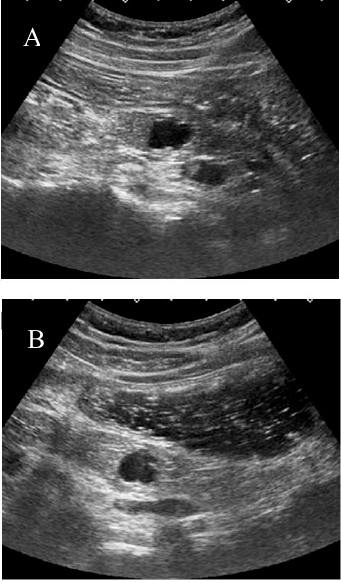
Figure 3. The liquid-filled stomach method. The pancreas tail is not well visualized due to gastric gas in normal examination ( A ). However, the pancreatic body to tail become clearly visualized after intake of milk tea with Fowler’s position ( B